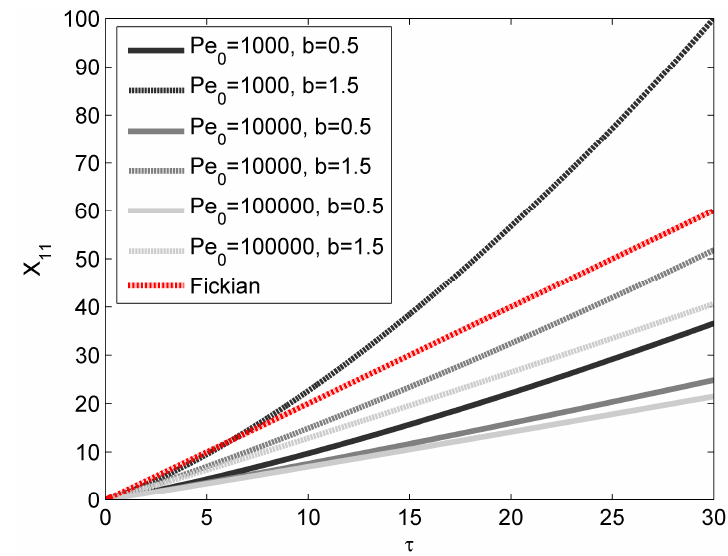
Figure 2. Longitudinal particle trajectory covariance for variable P é clet numbers and scaling exponents. The red-dotted line refers to Fickian linear behavior corresponding to a single-scale log-conductivity field (exponential or Gaussian log- K covariance) characterized by the truncated-hierarchy variance and by an integral scale equal to the initial plume size.